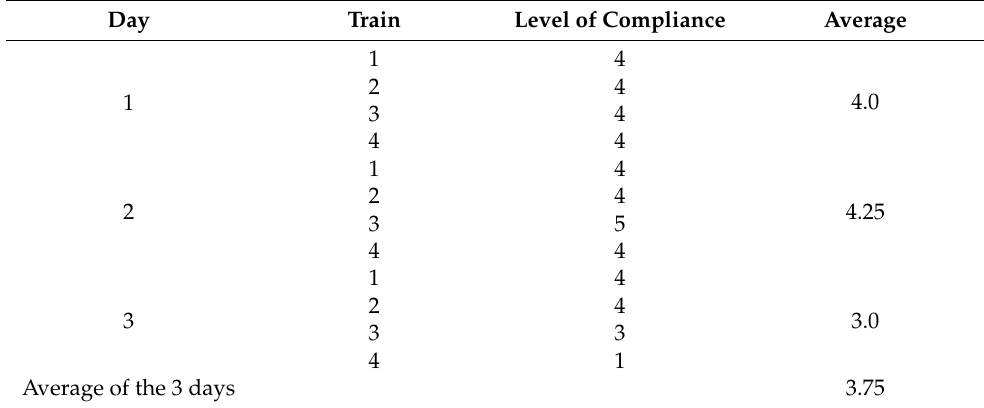
Table 4. Evaluation method of the level of compliance for the yellow safety line in Hospital Station in the Valparaiso Metro in off-peak